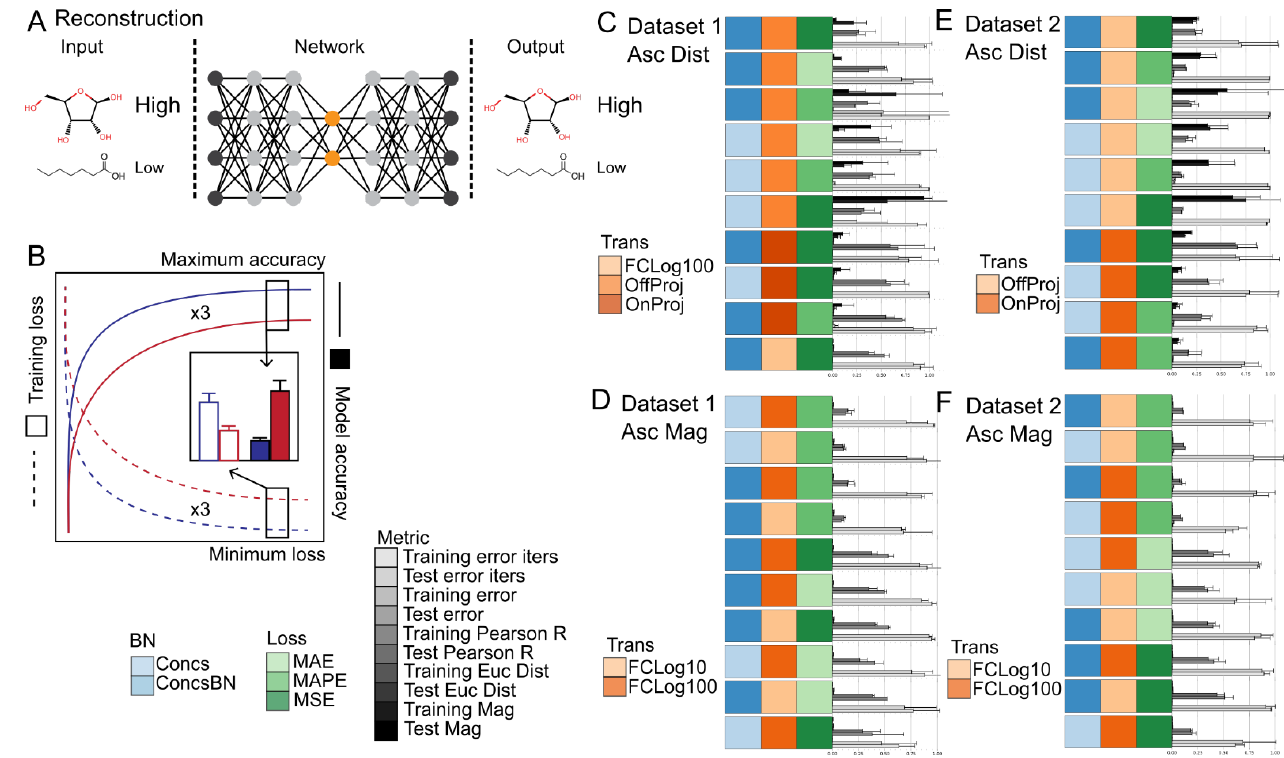
Figure 4. Summary of the reconstruction task and evaluation procedure. ( A ) Schematic of the machine-learning reconstruction and joint reconstruction and classification tasks using metabolite levels as input and sample labels as output. ( B ) Diagram of the evaluation procedure. Summary of Reconstruction results for Dataset 1 ( C , D ) and Dataset 2 ( E , F ). The bars represent the model training iterations to minimum loss function scores, the model minimum loss function scores, and the model metric scores ( n = 2–3 training runs). Error bars represent the standard deviation ( n = 2–3 training runs). Reconstruction metrics for Pearson’s R, Euclidean distance, and Absolute percent difference are shown. Model training iterations to minimum loss, model loss scores, Euclidean distance, and Absolute percent difference are scaled from 0 to 1. The Imputation method of Sampling was used for all models. The data are sorted in ascending order based on Euclidean distance ( C , E ) and Absolute percent difference ( D , F ). The top 10 models are shown. Source data are provided in Tables S4 and